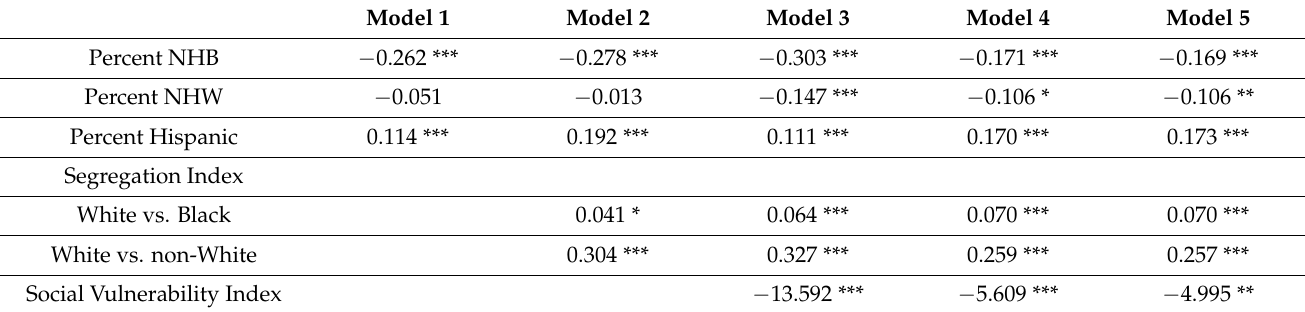
Table 2. Multiple regression models to predict percent of county residents fully vaccinated for COVID-19.